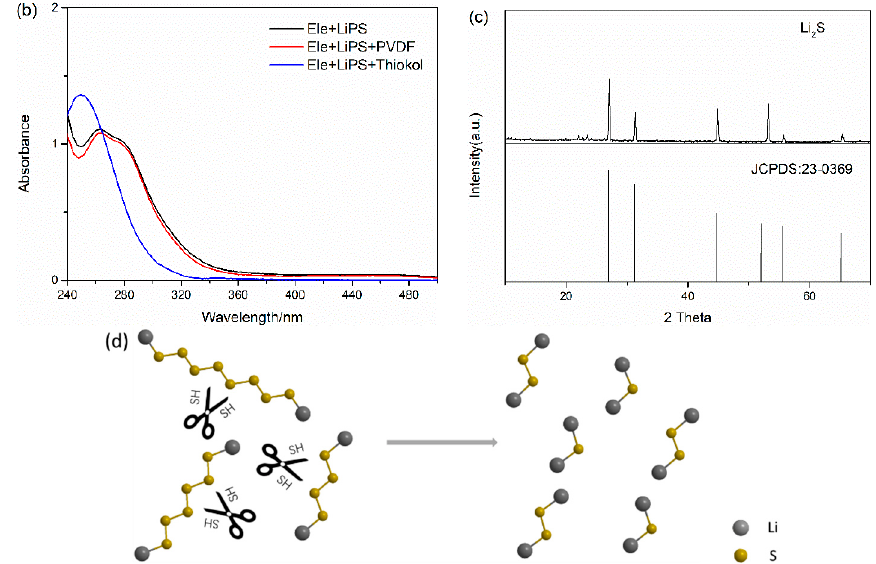
Figure 4. ( a ) Photos of the polysulfides in the electrolyte without and with two kinds of binders. Long-chain polysulfides (Li 2 S 6 , LiPS) in the electrolyte (1), long-chain polysulfides and PVDF in the electrolyte (2), long-chain polysulfides and Thiokol in the electrolyte (3), Li 2 S in the electrolyte (4); ( b ) UV–vis absorption spectra of polysulfides in electrolyte (black), long-chain polysulfides and PVDF in the electrolyte (red), long-chain polysulfides and Thiokol in the electrolyte (blue); ( c ) XRD pattern of the resulting precipitate collected from Figure 4 a -(2); ( d ) Schematic illustration of the reactions between polysulfides and Thiokol in the cathode.